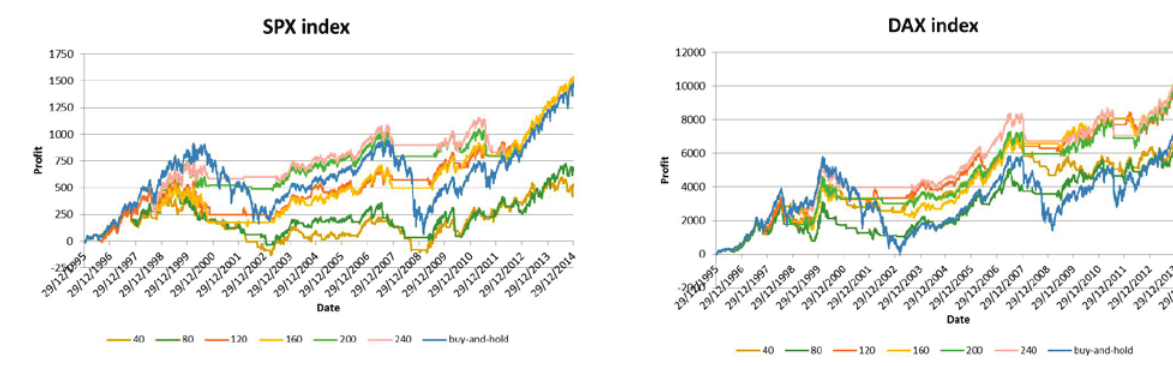
Figure 9. Profits of our strategy and “buy-and-hold” on SPX index (without transaction costs)